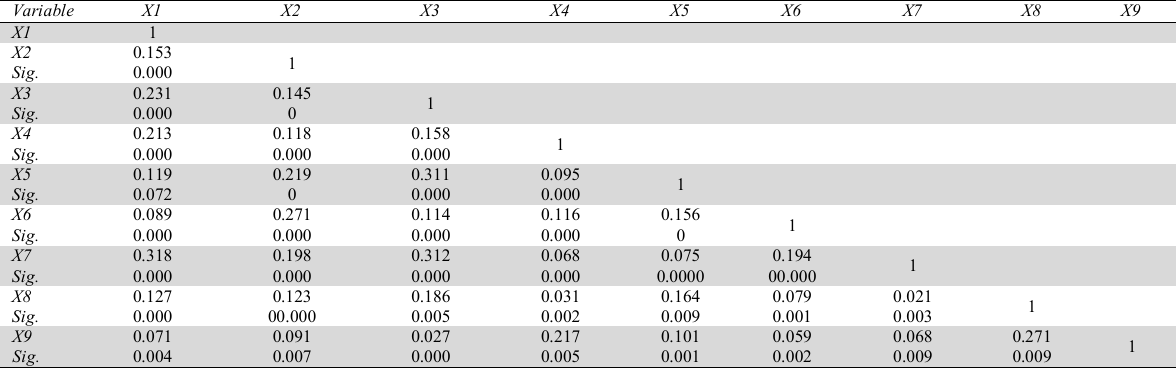
Pearson Correlation for variables